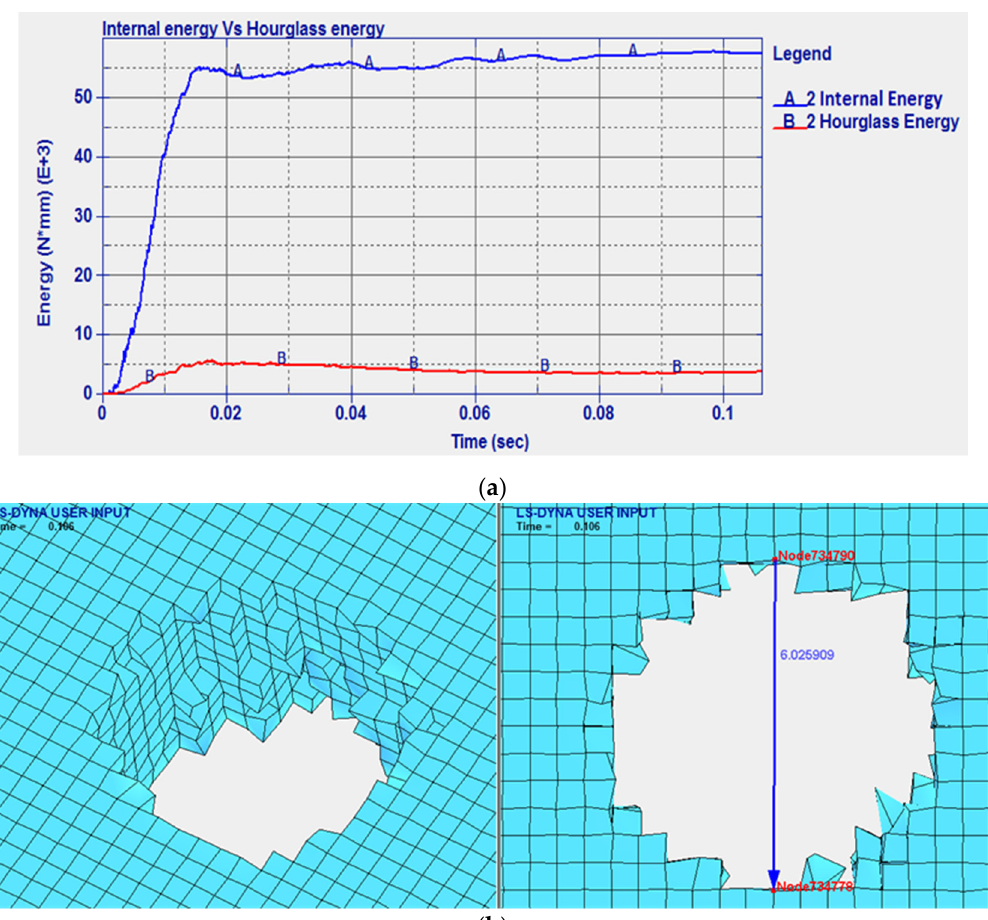
Figure 8. ( a ) Internal energy vs. hourglass energy, and ( b ) the 3D and 2D damage marks of the projectile penetrating the NiTi plate.